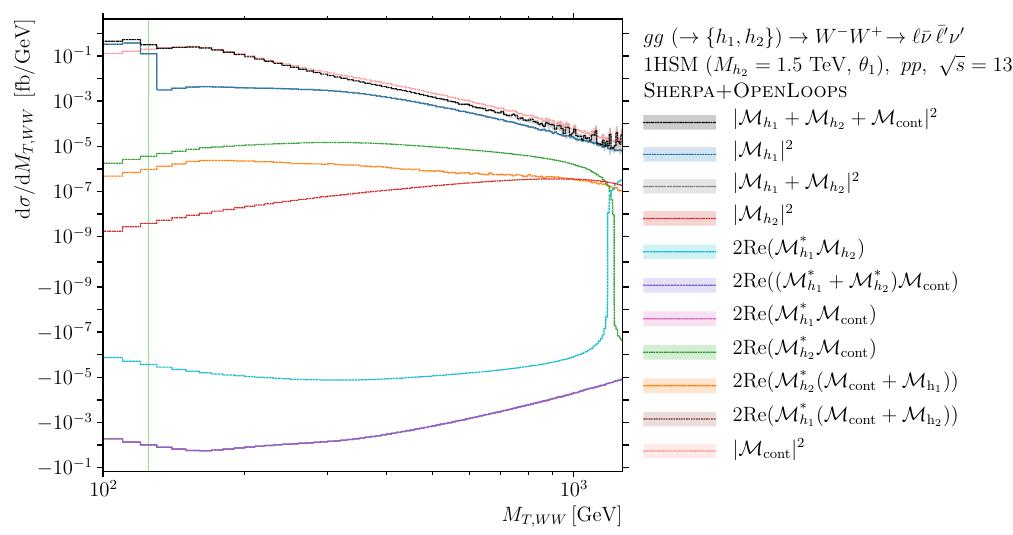
+ (cid:26) ¯ ν ¯ (cid:26) (cid:30) ν (cid:30) in →